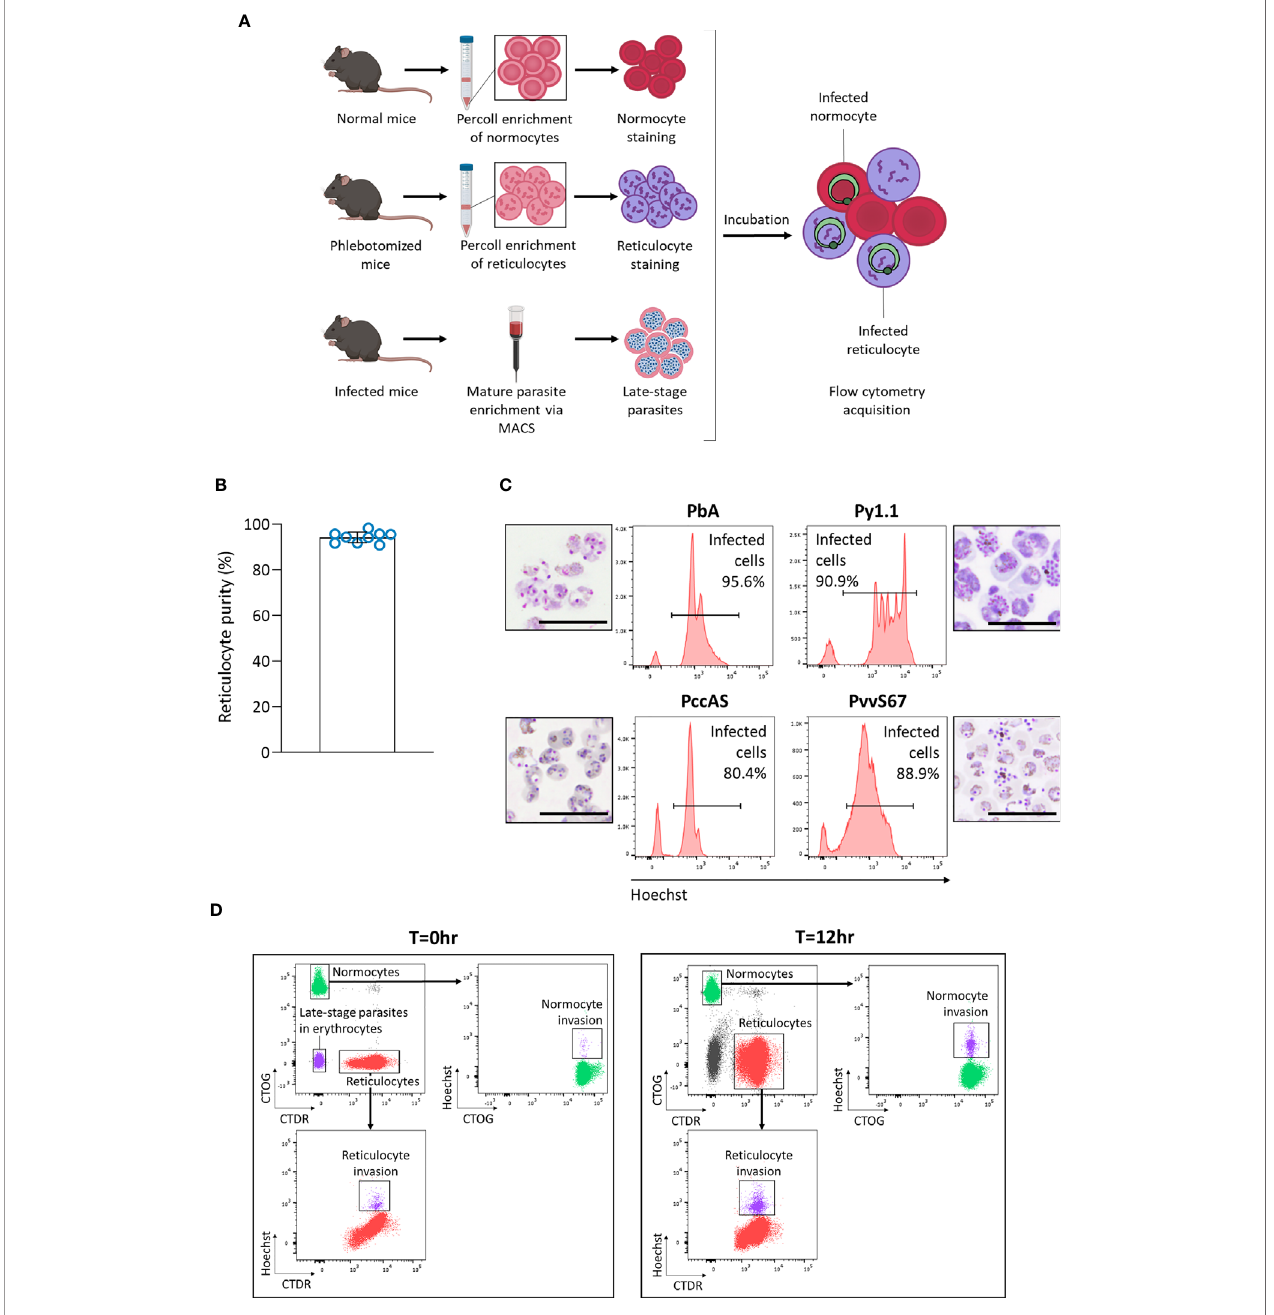
FIGURE 3 | Development of an ex vivo tropism assay to measure erythrocyte preference of rodent malaria. (A) Schematic showing work fl ow of the assay. Normocytes are enriched by Percoll density centrifugation of blood taken from normal mice (untreated and uninfected). Reticulocytes are enriched similarly from blood taken from mice that underwent a phlebotomy routine. Enriched cells are then stained with different fl uorescent dyes. Late-stage parasites are enriched from infected blood via magnetic-activated cell sorting (MACS). The cells are then incubated together for 12 hrs and measured by fl ow cytometry. Images were created on Biorender.com. (B) Reticulocyte purity (based on thiazole orange staining) after the two-step reticulocyte enrichment. Data from 9 independent experiments. Error bars represent standard deviation. (C) Late-stage parasite purity post-MACS for the four major rodent malaria strains. Histogram showing Hoechst levels and Giemsa-stained thin smears of enriched cells. Most of the enriched cells consist of late-stage parasites. Scale bar of microscopy images = 20 µm. PbA, P. berghei ANKA. Py1.1, P. yoelii 17X1.1. PccAS, P. chabaudi chabaudi AS. PvvS67, P. vinckei vinckei S67. (D) Flow cytometry gating strategy. At T=0hr, reticulocytes stained with CellTracker Deep Red (CTDR) are easily distinguishable from normocytes stained with CellTrace Oregon Green (CTOG). Late-stage parasites within erythrocytes are negative for both dyes. At T=12hr, new invasions into reticulocytes and normocytes can be detected by